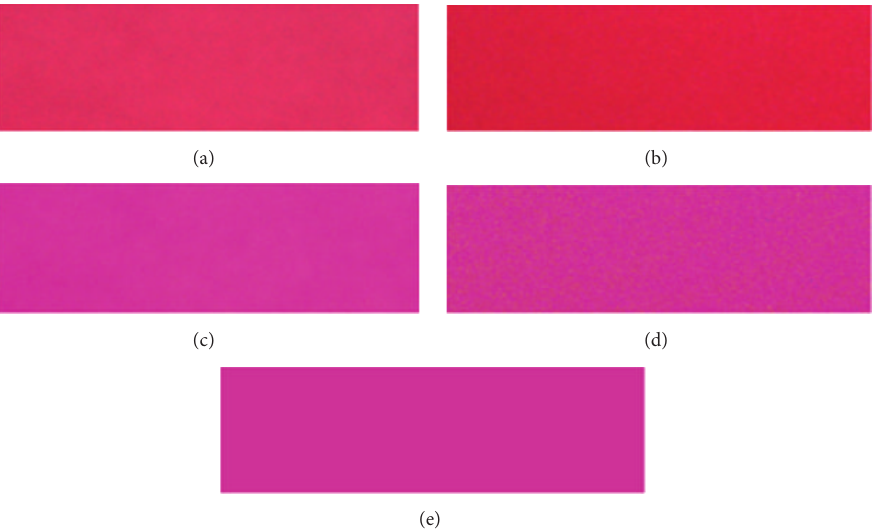
Figure 7: The comparison of 225 M color patches. (a) Before calibration under D65 illuminator and (b) before calibration under LED illuminator and (c) obtained by Φ RGB → sRGB ( ad 65) and (d) obtained by Φ RGB → sRGB ( LED ) and (e) theoretical images of standardized tristimulus values.